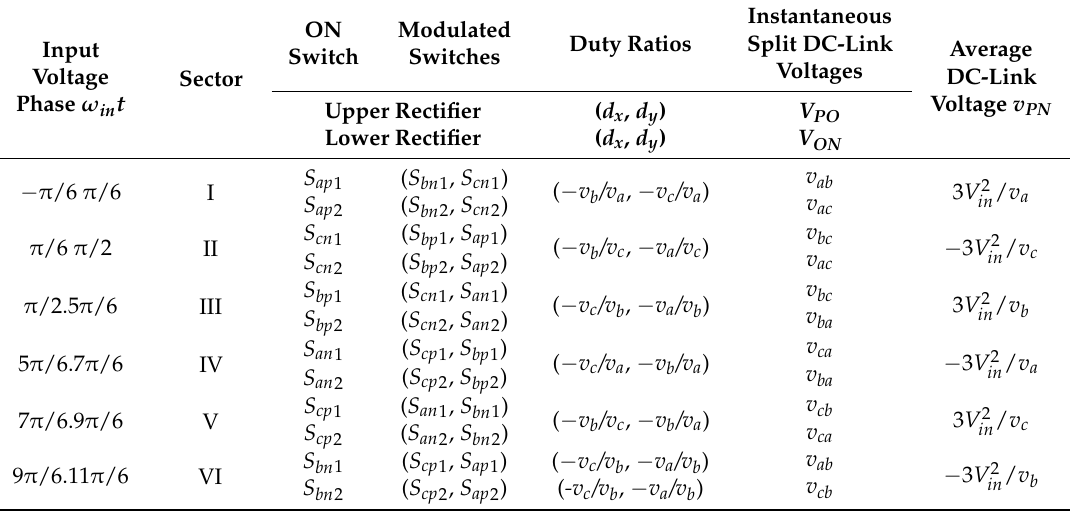
Table 3. Switching state and average DC link voltage according to the input current